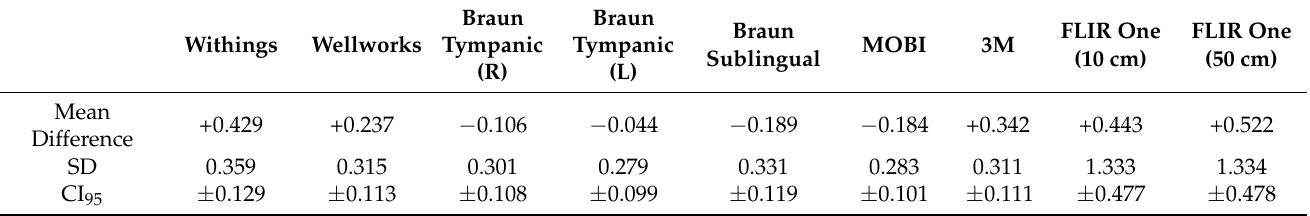
Table 2. Mean difference, standard deviation and 95% confidence interval between each device and the gold standard.